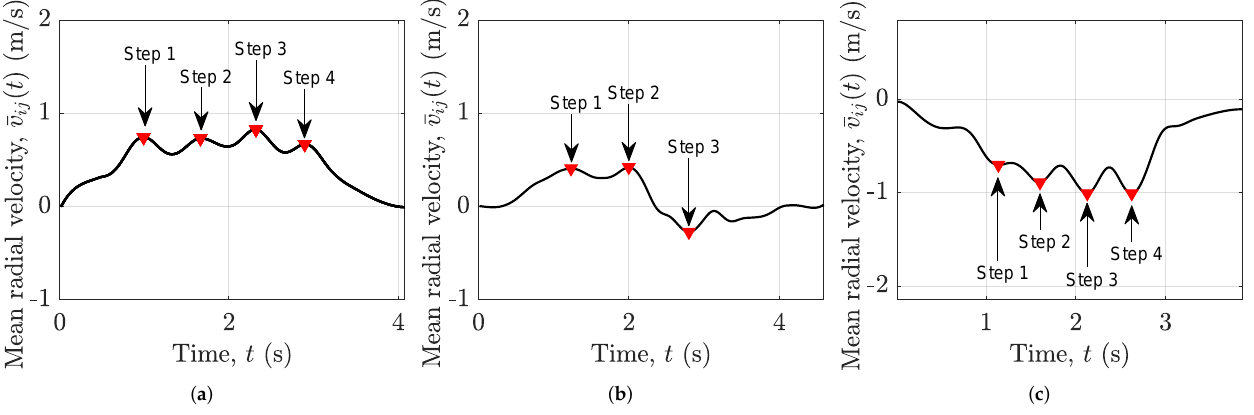
Figure 5. For a SISO radar, the number of steps detected from the smoothed mean radial velocity ¯ v 11 ( t ) of a human walking activity according to ( a ) Scenario 1, ( b ) Scenario 2, and ( c ) Scenario